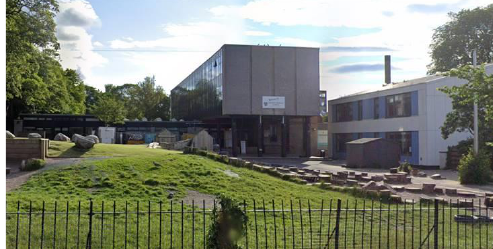
Figure 4. School B. Figure 4. School B.